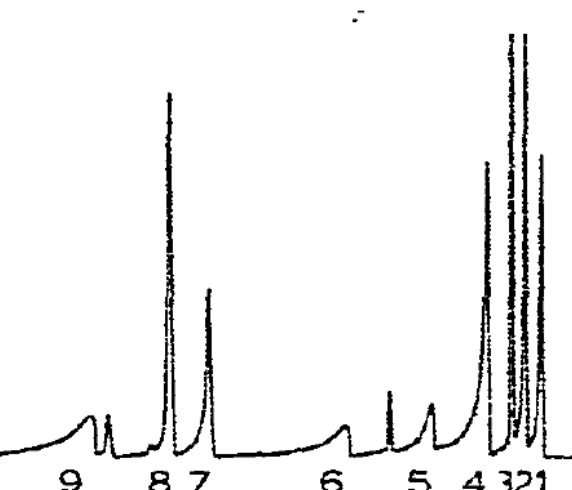
Figure 8. GC with glass capillary without surface deactivation prior to coating with polyethyleneglycol. Analytes 1-9: alkylamines. Fig- ure taken from ref. [69] with permission and